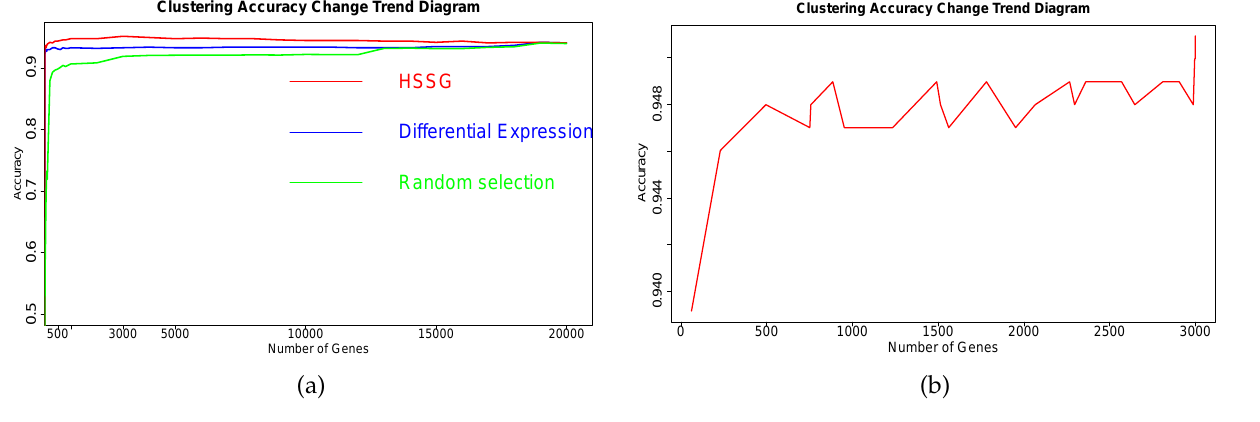
Figure 3. The change curve of cluster accuracy in selecting genes for identifying two subtypes. ( a ) Curve of the accuracy of three different gene screening methods changing with that number of added genes; ( b ) With the addition of gene modules, the accuracy changed with the number of adding